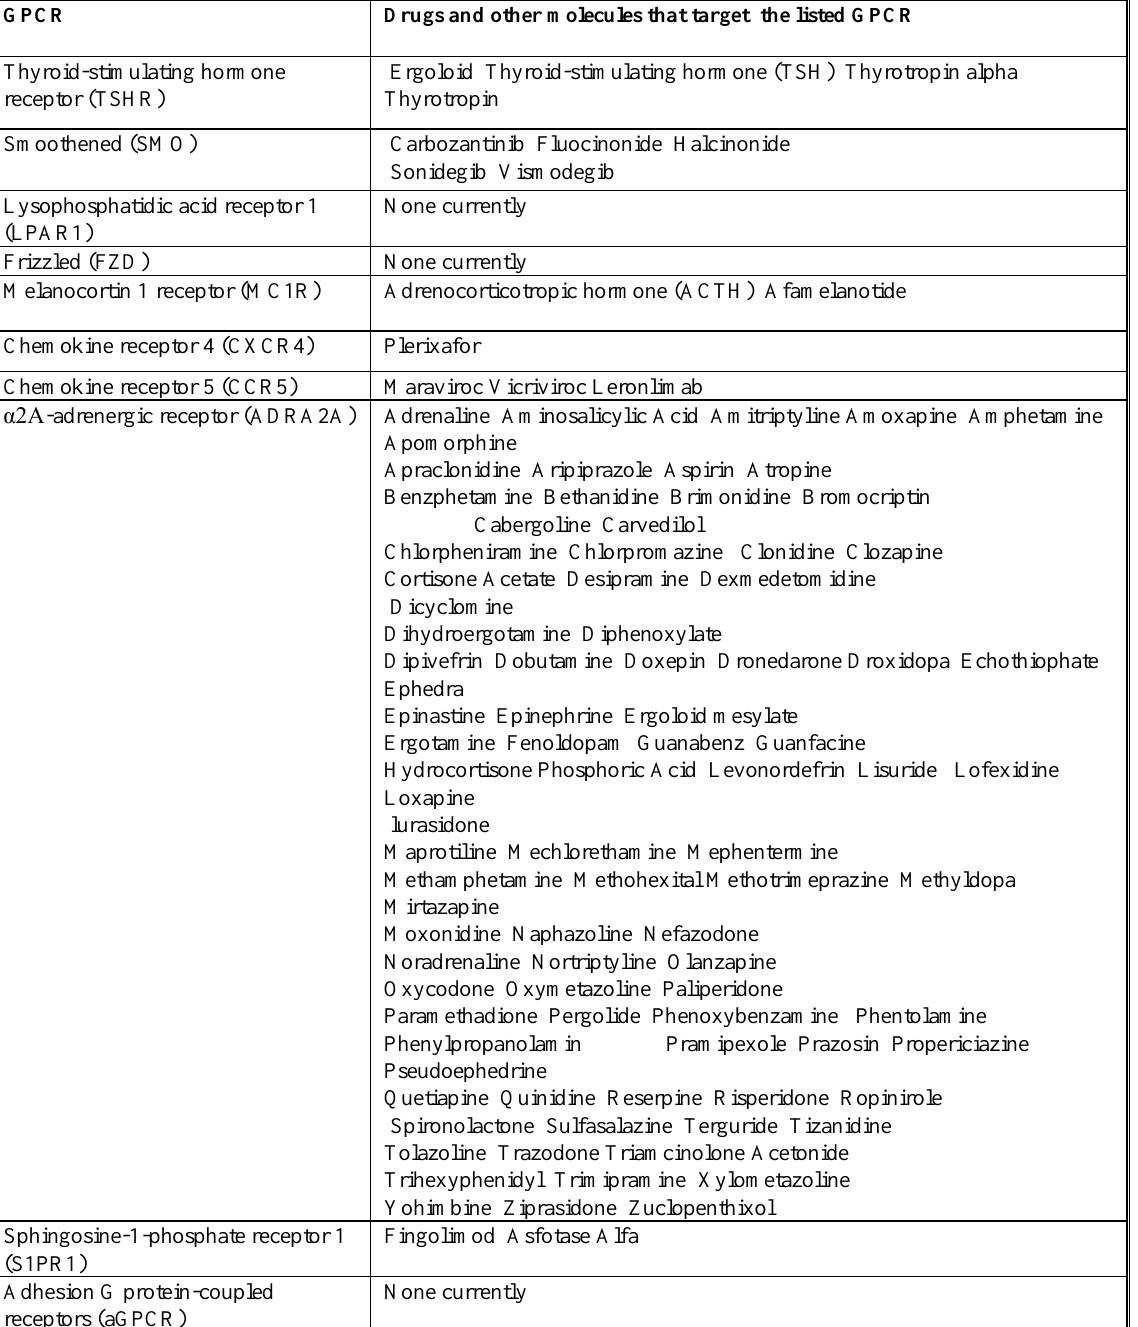
Table 2. Range of drugs targeting selected G protein-coupled receptors (GPCRs) (112-115) GPCR Drugs and other molecules that target the listed